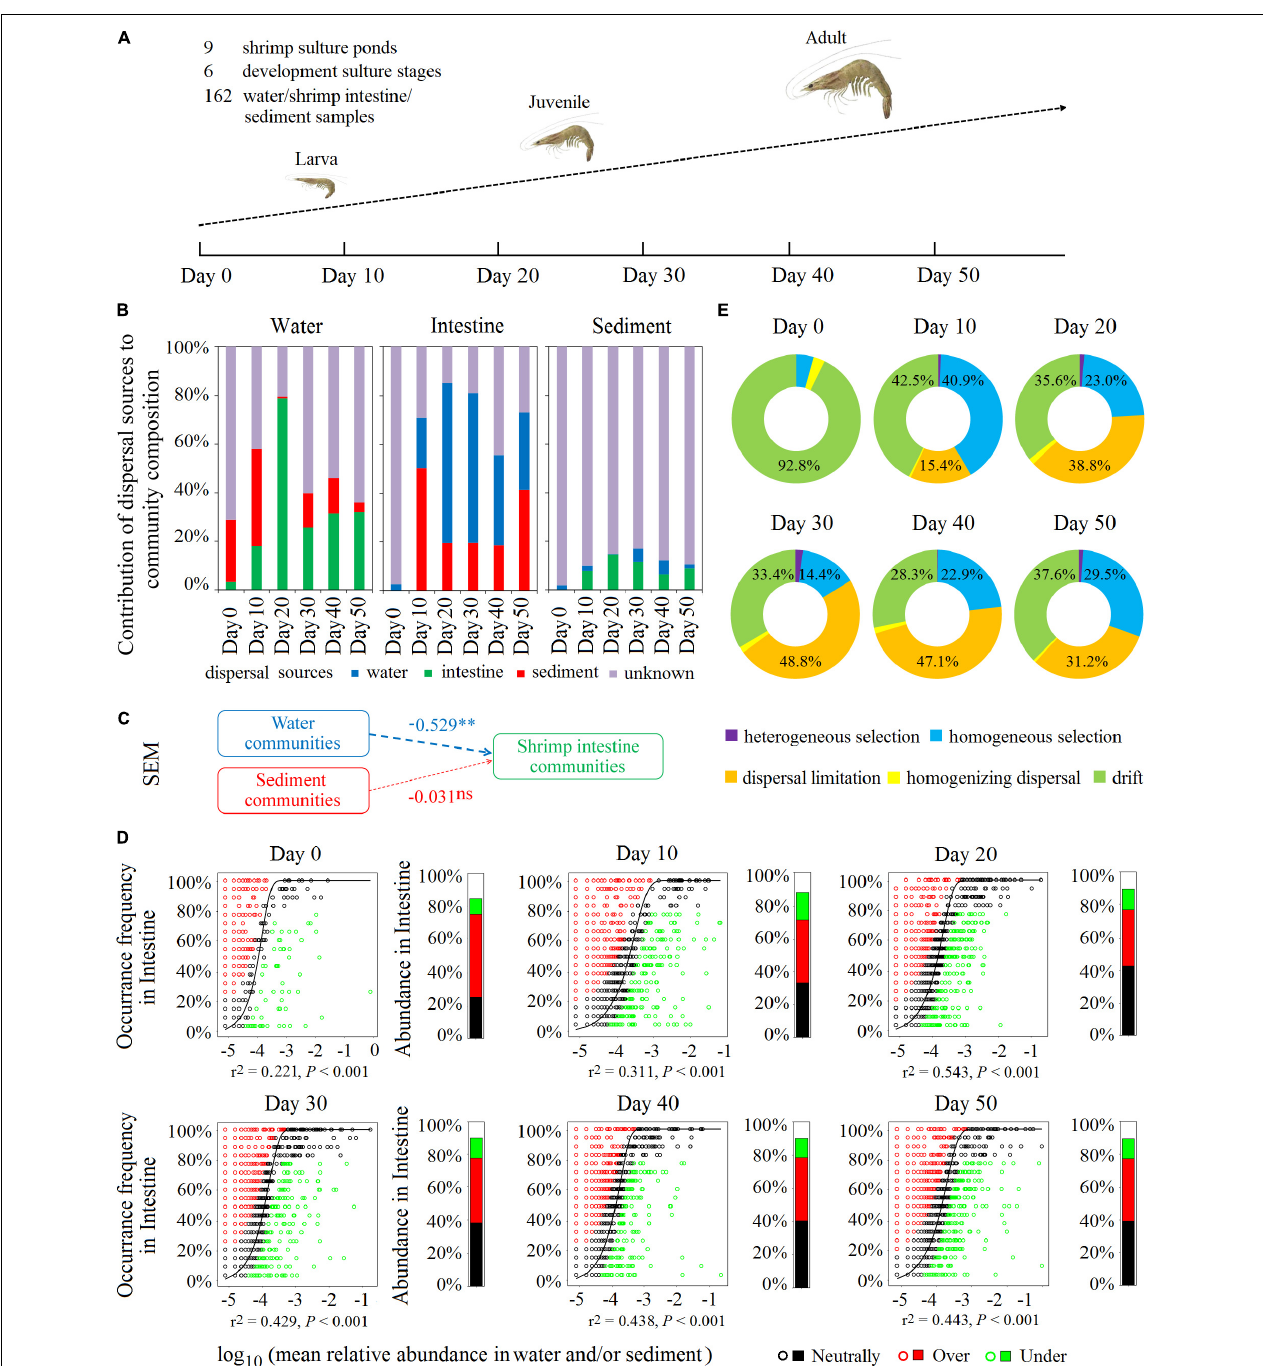
FIGURE 5 | Environmental water and sediment microbiota contributed to community succession of the shrimp intestinal microbiota in the SCPE during shrimp developmental stages. (A) Nine shrimp culture ponds were selected in the study area, which was located at Zhuhai in China. Water, shrimp intestine, and sediment samples with nine samples each for each time at six developmental stages: day 0, day 10, day 20, day 30, day 40, and day 50 post-larval shrimp inoculation. Microbial communities of the surrounding water and sediment mainly contributed to shrimp intestinal microbiota in different culture stages. (B) SourceTracker analysis of the contribution of water, shrimp intestine, and sediment source communities to each other’s communities. (C) The SEM shows environmental microbial community drivers of shrimp intestinal microbiota in the SCPE. The directed graph of SEM and the GoF statistic value was 0.370. Each box represents an observed or latent variable. Path coefficients are reflected in the width of the arrow with dashed arrows as significantly negative effects. ∗∗ : P < 0.01, ns: no significance. (D) The Sloan neutral model was applied to shrimp intestine communities with their corresponding surrounding water and/or sediment communities as the sources. Stacked bar chart depicts the relative abundance of sequences in the neutrally distributed (black), overrepresented (red), and underrepresented (green) OTUs in shrimp intestine. (E) The contribution of ecological processes to the microbial assembly of shrimp intestine habitat.